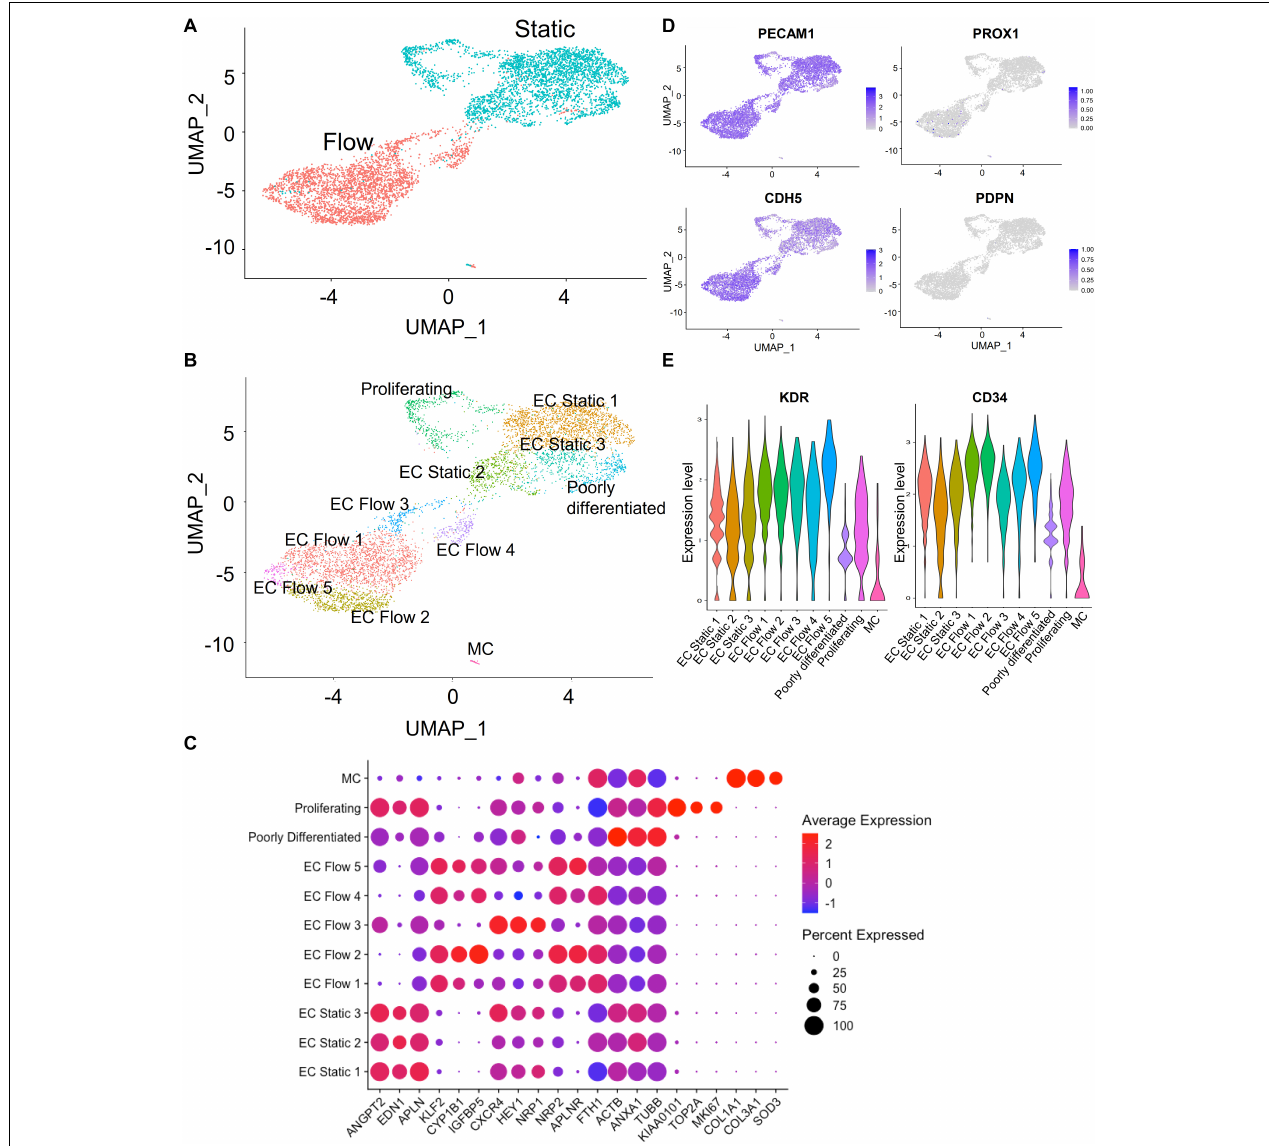
FIGURE 2 | Characterization of single-cell RNA sequencing clusters (HEL47.2 cells). (A) , UMAP (Uniform Manifold Approximation and Projection) plot of flow and static cells. (B) , UMAP plot of the delineated clusters. (C) , Dot plot for marker genes of the delineated clusters. (D) , Feature plot of blood EC ( PECAM1, CDH5 ) and lymphatic EC ( PROX1, PDPN ) EC marker gene expression. (E) , Violin plot of EC marker genes ( KDR, CD34 ) in all identified clusters.